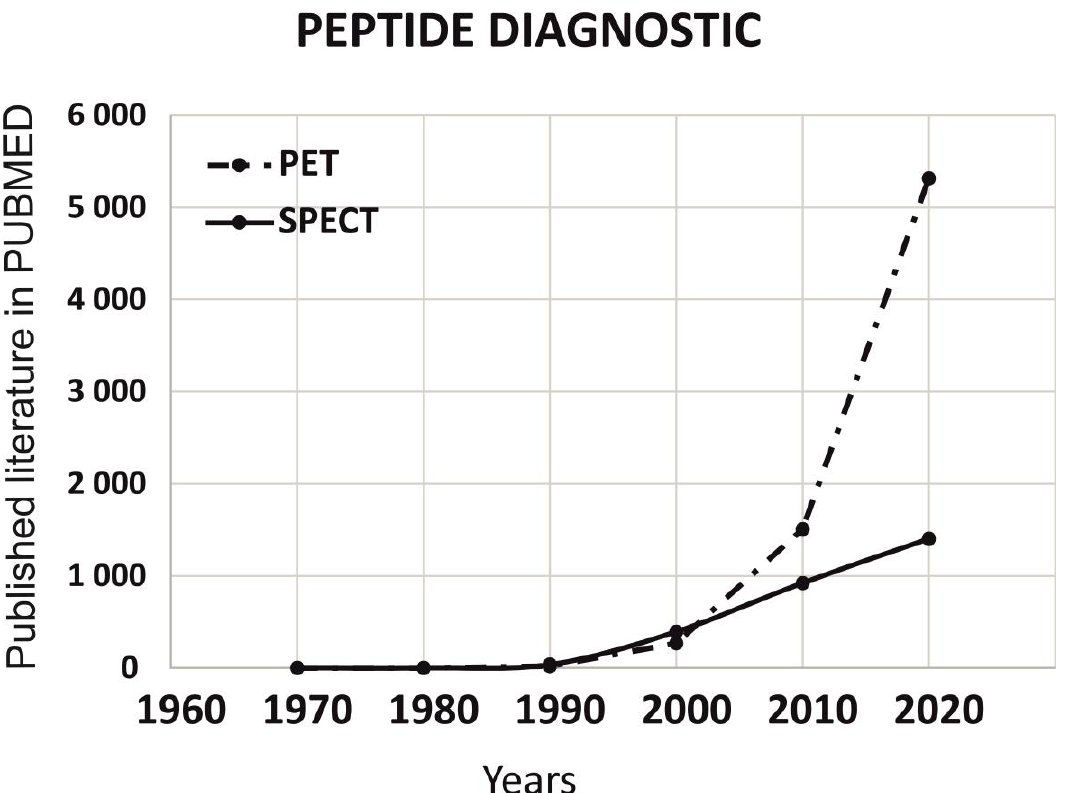
Figure 5. Understanding the role of peptides in imaging diagnostics (PET and SPECT) through the published literature on PUBMED in the last five decades (1 January1970 to 31 December 2020). Comparison of the data published with the keywords peptide diagnostic and sub-keywords (PET and SPECT). PET has grown drastically in last